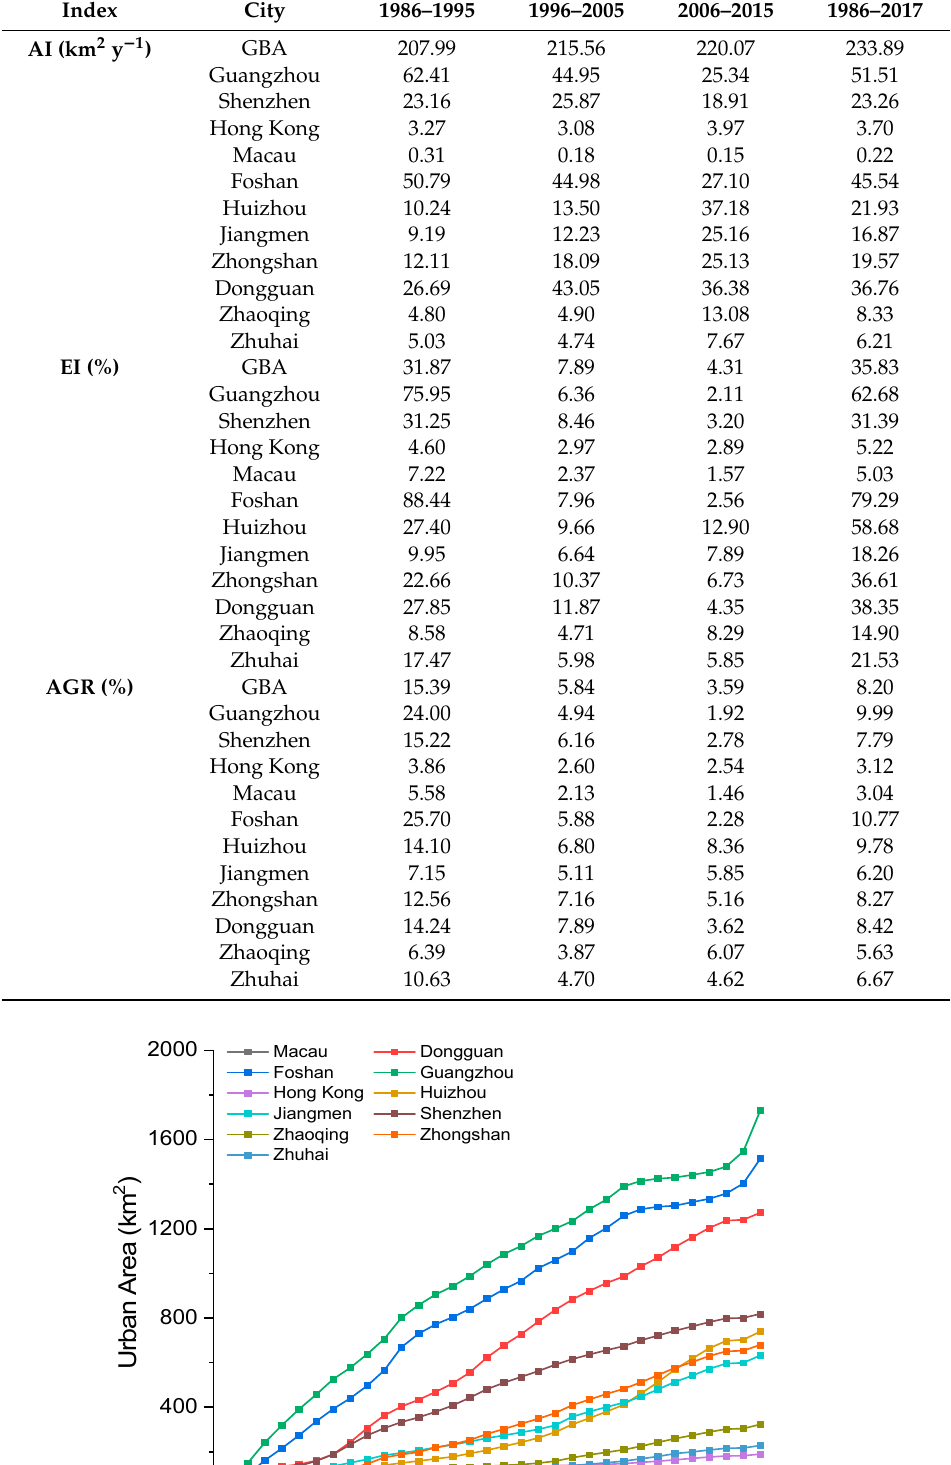
Table 4. Annual increase ( AI ) in urban area (km 2 y − 1 ), expansion intensity ( EI ) (%), and annual growth rate ( AGR ) (%) for cities in the GBA during 1986–2015.